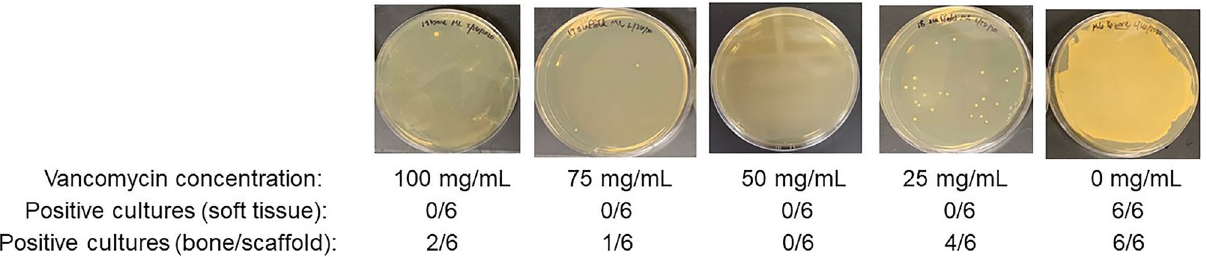
Figure 6. Bacteriological analysis of the K20 scaffold as a function of antibiotic concentration. The K20 scaffold was saturated in a solution containing the indicated amounts of vancomycin for 1 h at room temperature. Scaffolds were then used to replace a 1 cm excised bone segment in infected rabbits. Scaffolds were left in place for 14 days, at which point the surgical site was opened and soft tissues samples swabbed for bacteriological analysis. The bone and its associates scaffold was then removed and homogenized before plating an aliquot on tryptic soy agar. All soft tissue samples were negative as indicated below each panel. Images shown for each antibiotic concentration are representative of rabbits in each experimental